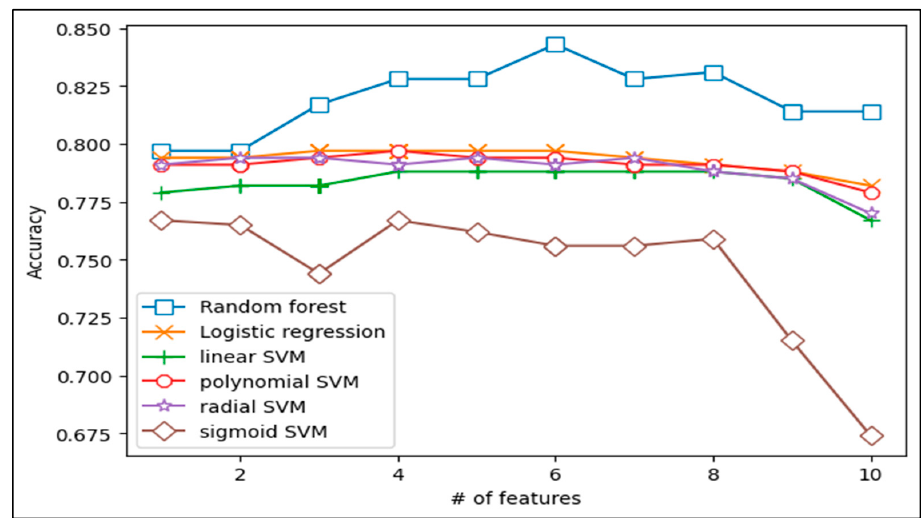
Figure 1. Comparison of Accuracy in Prediction Models.